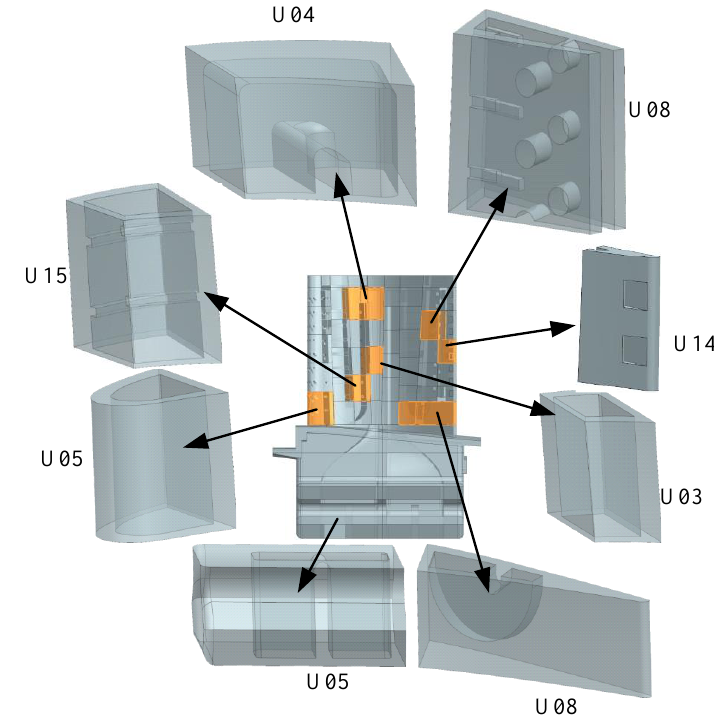
Figure 21. Adaptive division results of one blade model.